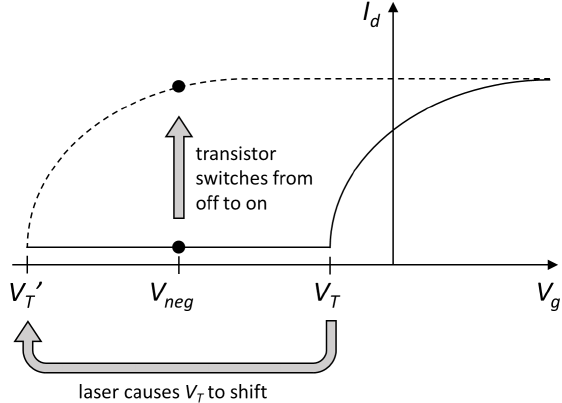
Figure 8: I d - V g graph before (full line) and after lasering (dotted line). The threshold